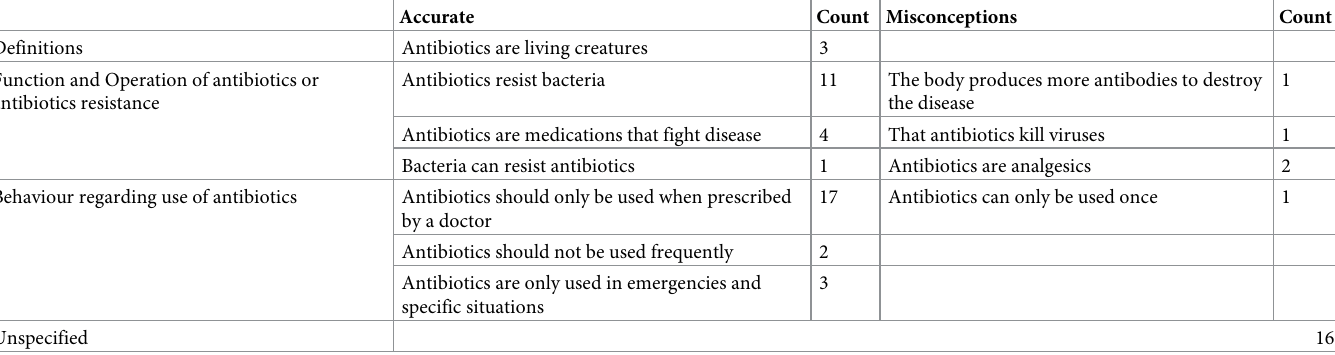
Table 11. Findings pertaining to Question 6: What did you learn about antibiotics in